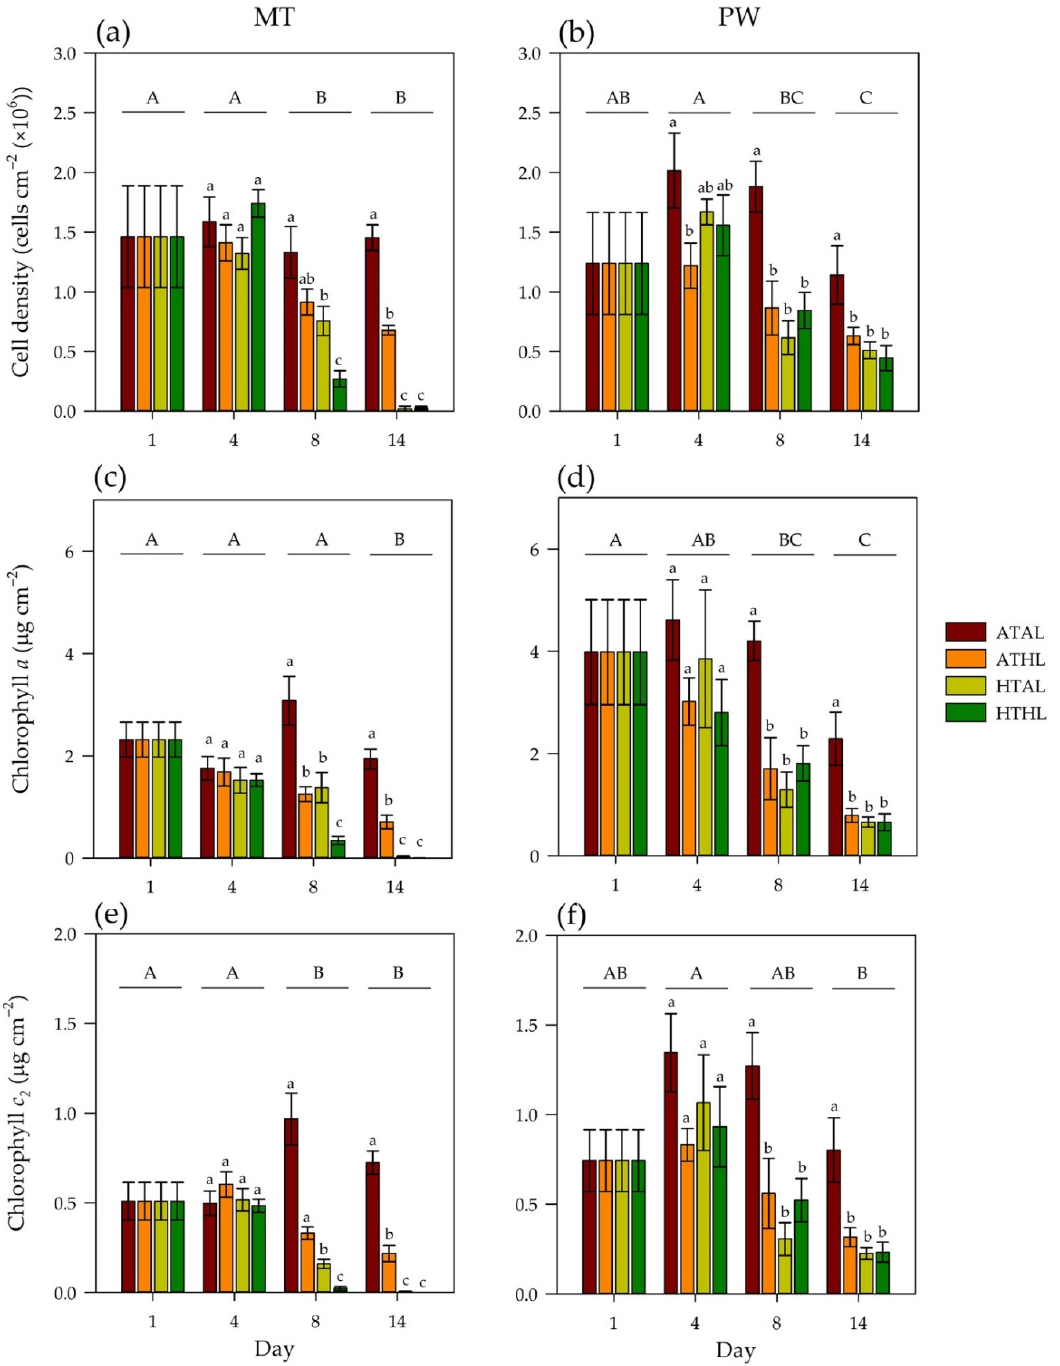
Figure 5. Symbiodiniaceae cell density ( a , b ), chlorophyll a ( c , d ), and c 2 ( e , f ) of P. acuta from MT and PW at each sampling time. Data are presented as mean ±SE (n = 4). A, B, C, D and a, b, c, d indicate significant differences by time and by treatment, respectively.